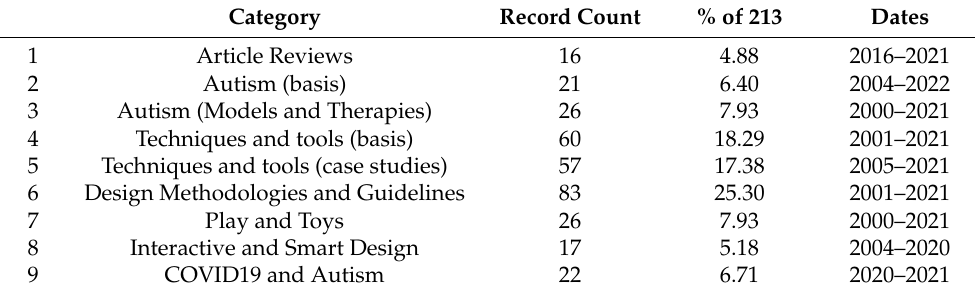
Table 2. Bibliography categorization.